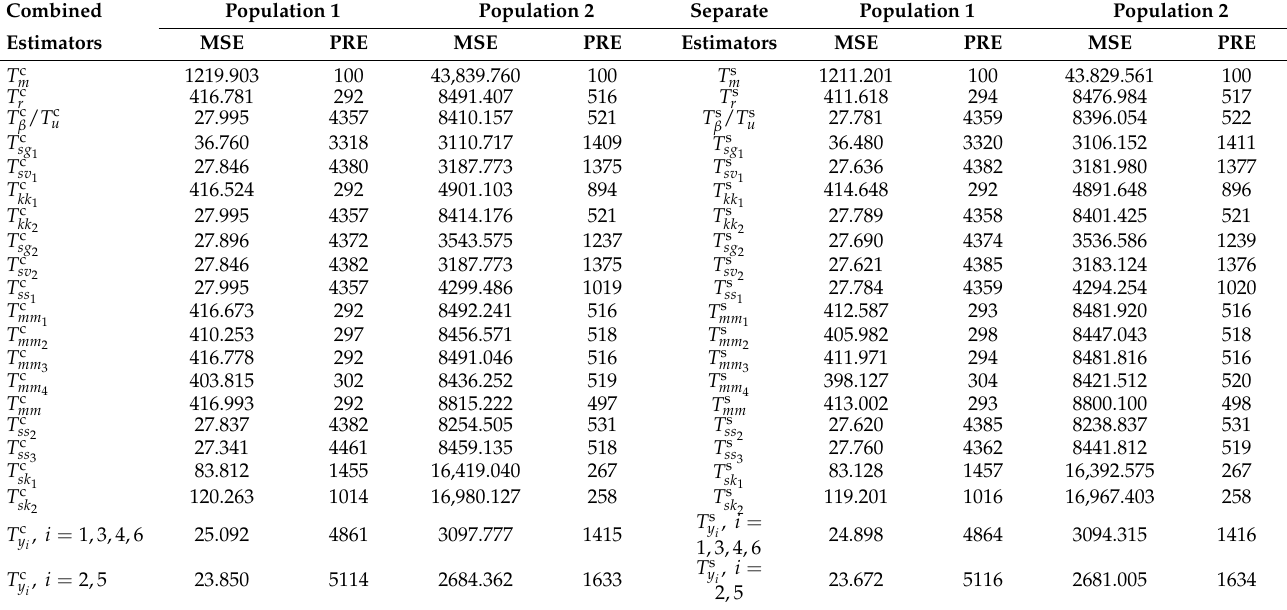
Table 3. MSE and PRE of combined and separate estimators utilizing real